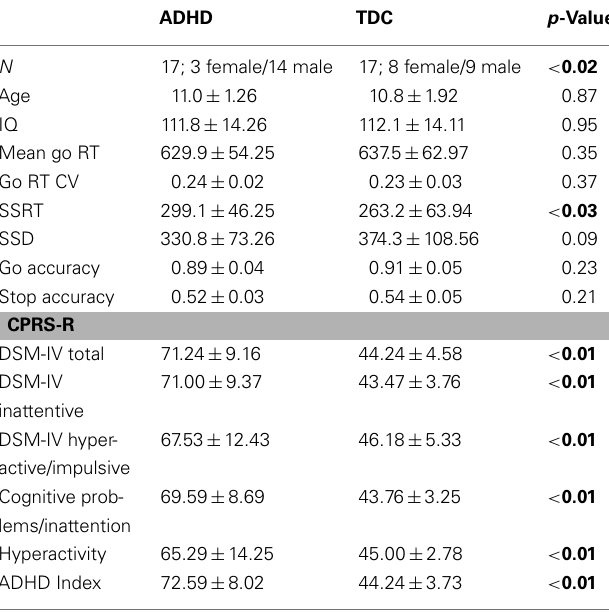
Table 1 | Participant characteristics and behavioral performance scores obtained from the stop signal task